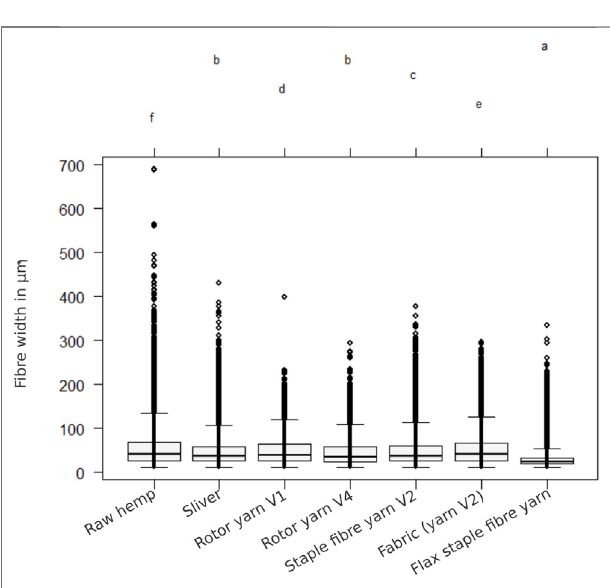
FIGURE 2 | Fibre width shown as Box-Whisker plots of fi bre bundles prepared from raw hemp, the sliver, the rotor yarn, the staple fi bre yarn, the fabric and the fl ax staple fi bre